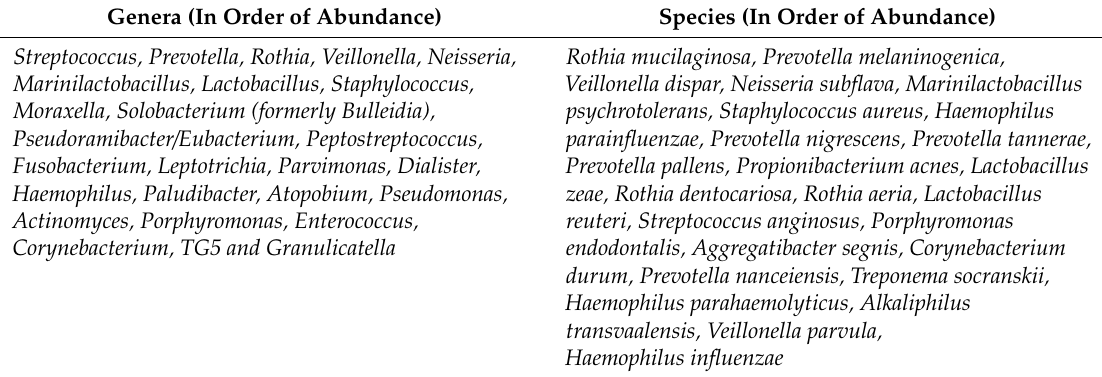
Table 2. The 25 most commonly identified genera and species across all endodontic samples examined, ordered by prevalence. Detailed taxonomic contributions are presented in Supplementary Material